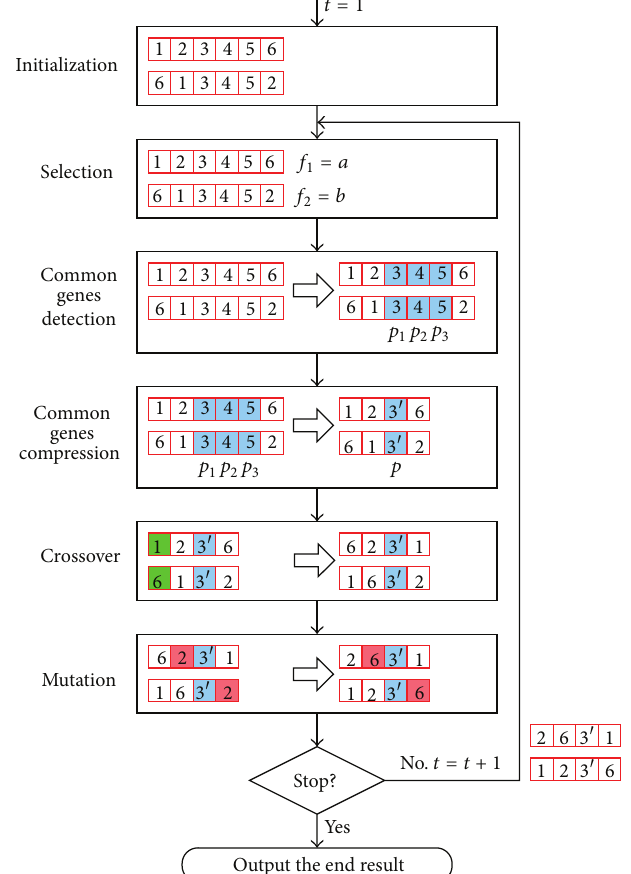
Algorithm 4: Outline of common genes compression algorithm.